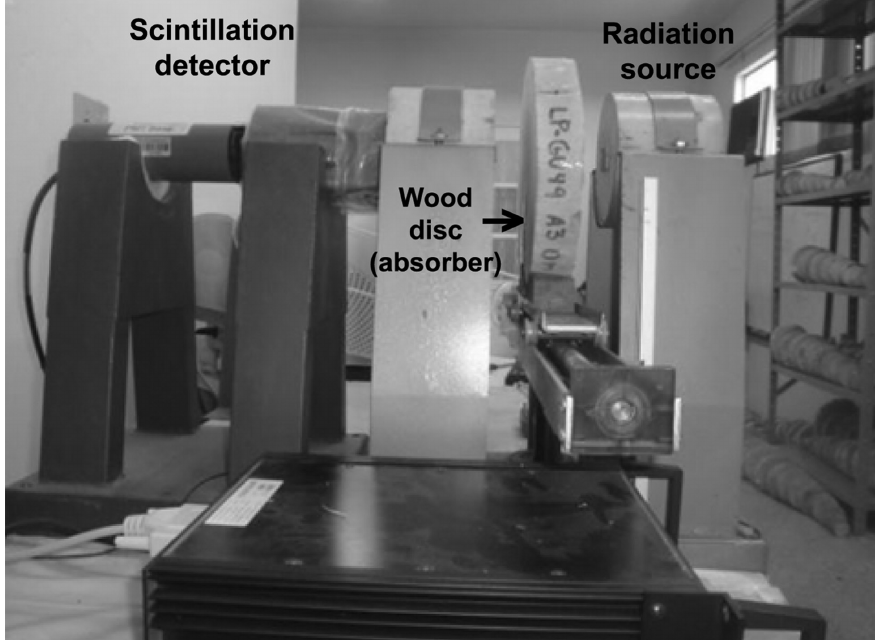
Figure 3 - Attenuation gamma radiation technique (Side detail of the sample movement between the source of radiation emission and the detection